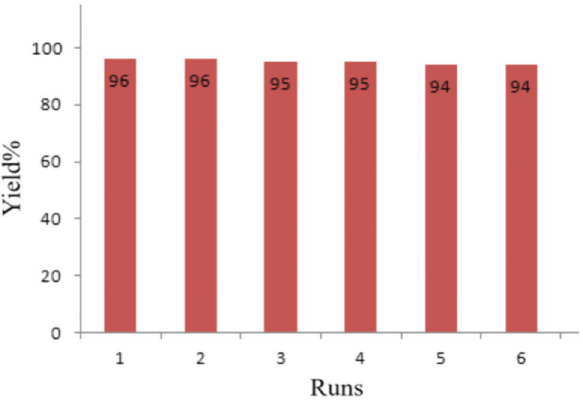
Figure 9. Recovery of nanosphere KCC-1@NH 2 .